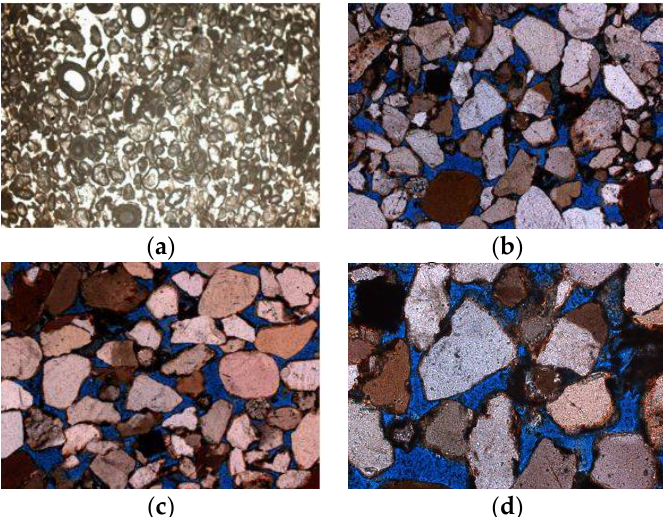
Figure 1. Sample microscopic images used in object tracking: ( a ) limestone from Slowinsko, magnification ×50; ( b ) sandstone from Solec, magnification: ×100; ( c ) sandstone from Solec, magnification: ×100 and rotation 120°; ( d ) sandstone from Solec, magnification: ×200.